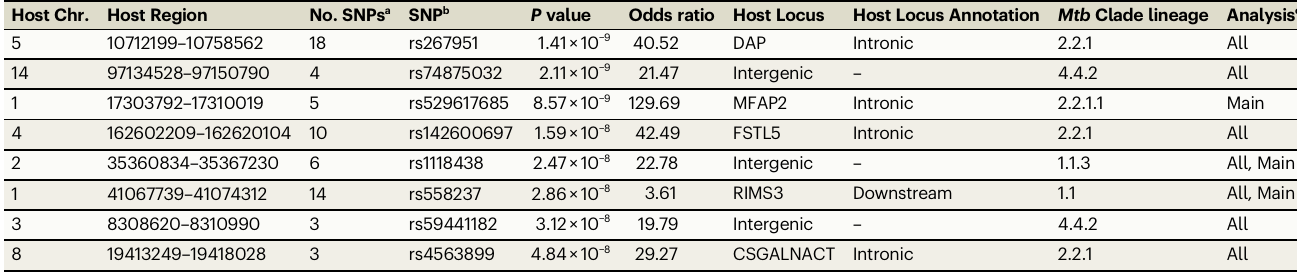
Table 1 | Genome-to-genome association results Host Chr. Host